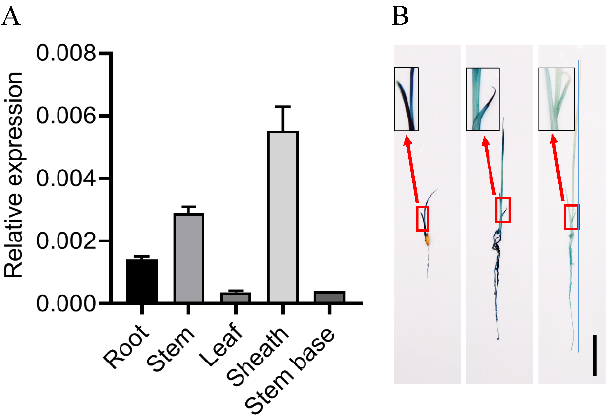
Figure 1. OsPIN1b expression in different tissues. ( A ) Tissue-specific expression pattern revealed by qRT–PCR. ( B ) GUS staining experiments in OsPIN1b promoter: GUS ( pOsPIN1b:GUS ) transgenic plants. Bar = 2 cm.